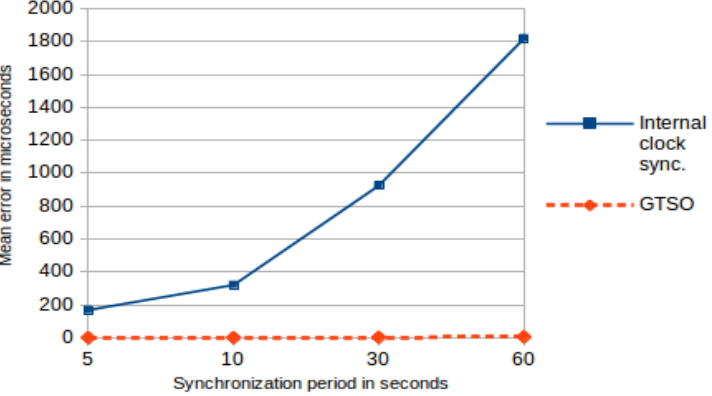
Figure 10. Mean error (arithmetic mean) of internal clock synchronization and GTSO, using the LSI as clock source.